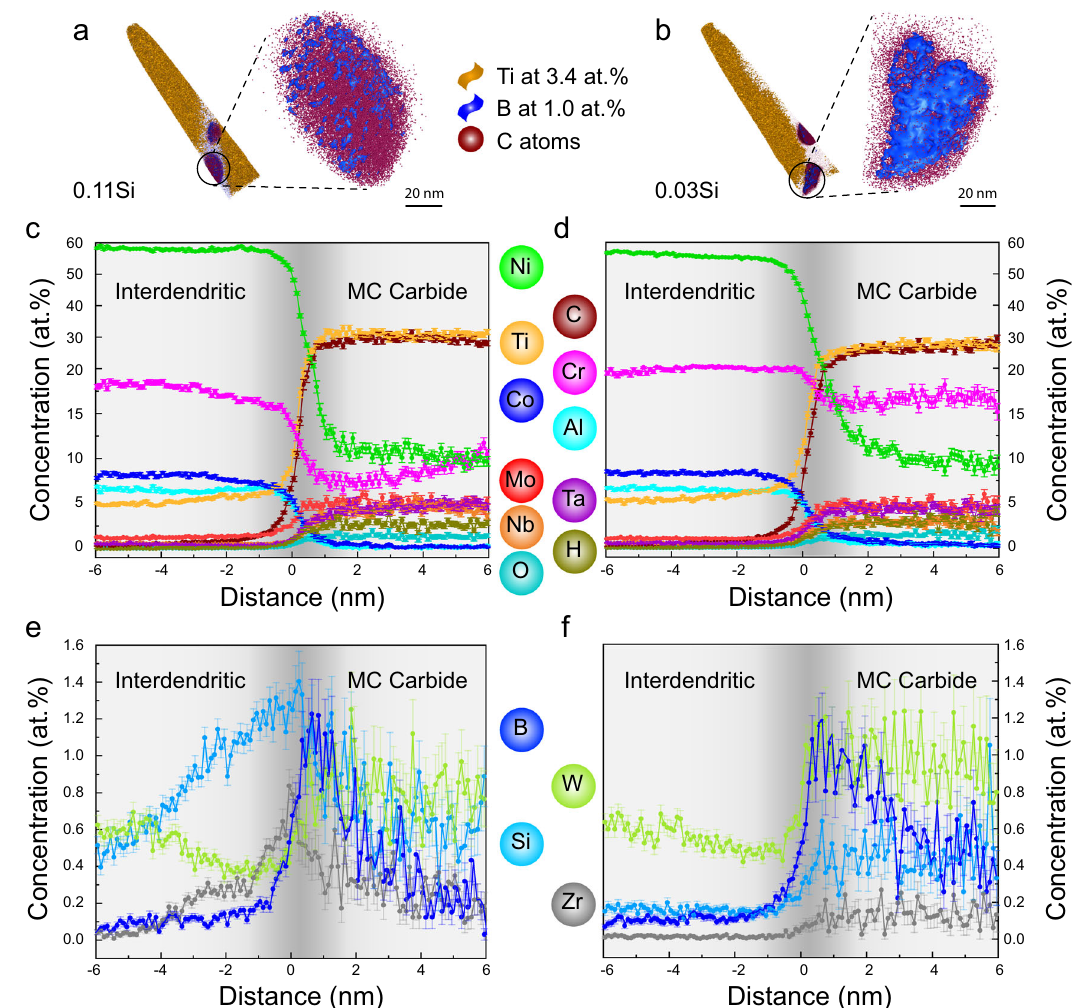
Fig. 5 | APT measurements of the interdendritic carbide compositions of the 0.11Siand 0.03Si samples.a , b APT tips are prepared inthe same region asFig.4. Carbides are only observed within the interdendritic regions of the two samples. Isosurfaces of 1.0at 0.% B shows that a layer of B is present surrounding the car- bides. c , d Proximity diagrams are made by 15at.% Ti to illustrate the composition